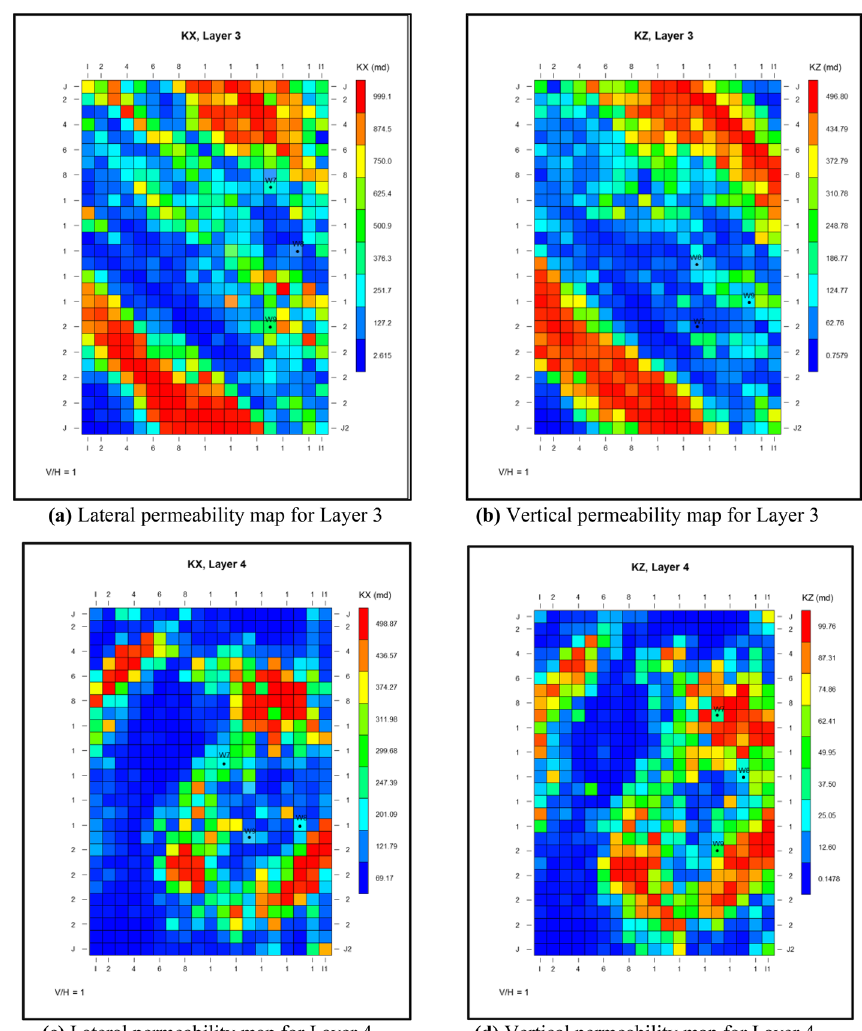
Fig. 3 Directional permeability distribution maps for various layers of the reservoir model